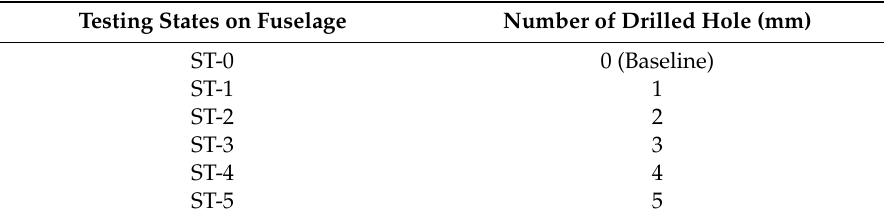
Figure 4. A part of real aircraft fuselage (specimen-3) used in experiment. Table 4. Simulated damage growth on the aircraft fuselage (specimen-3).